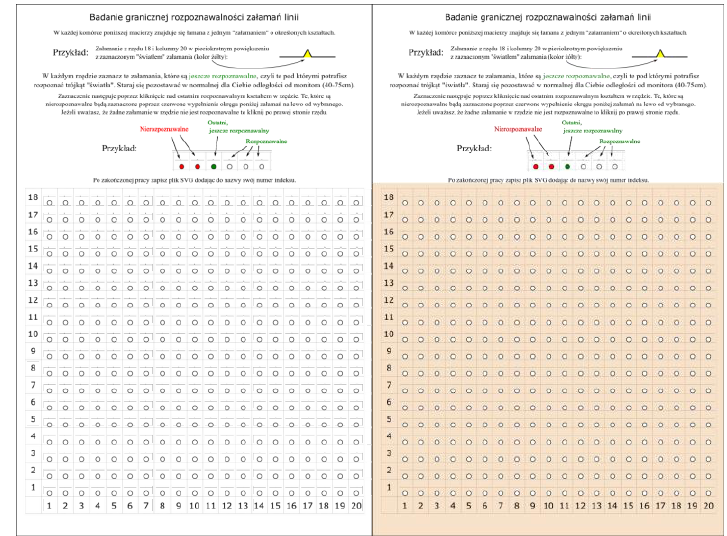
Figure 5. Sample interactive questionnaires: black and white card (BW) ( left ); and colour card with a chromatic background and a sign (K2) ( right ).